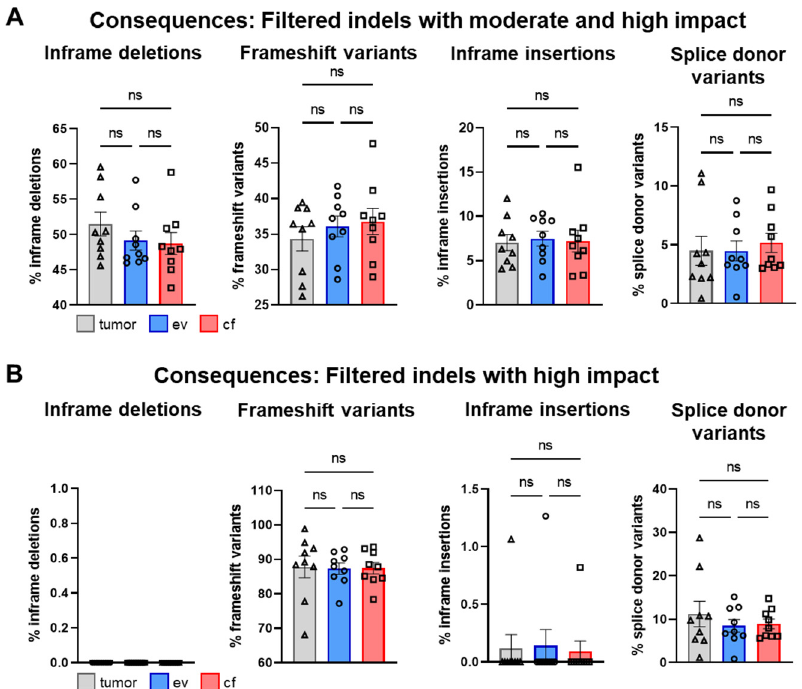
Figure 11. Analysis of consequences for indels. ( A ) Mean percentage amount of most prevalent consequences in tumor-, ev- and cfDNA of total consequences across all patients for indels with moderate and high impact and ( B ) indels with high impact. Statistical tests: ( A , B ) Repeated-measures one-way ANOVA with Tukey multiple comparisons test; ns: no significant difference.